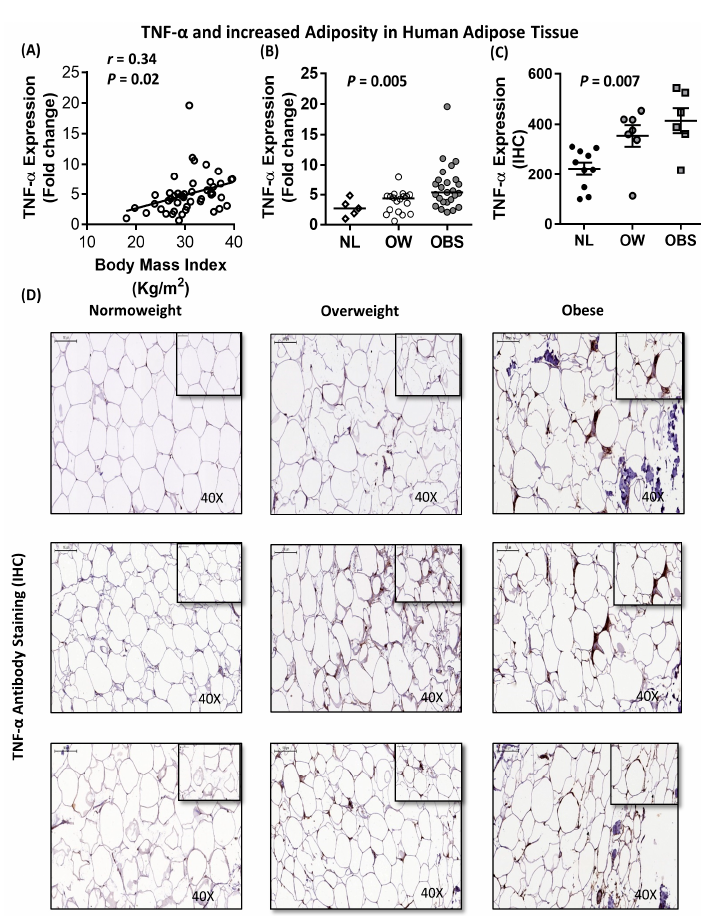
Figure 9. Association between TNF- α and increased adiposity in human adipose tissue. Subcutaneous adipose tissue was obtained from individuals with normoweight, overweight or obesity. ( A ) Direct correlation between adipose tissue TNF- α mRNA expression and the BMI. ( B , C ) Increased adipose tissue TNF- α mRNA and protein expression with increasing adiposity. TNF- α mRNA expression was detected by real-time RT-PCR and represented as fold change over controls. TNF- α protein expression was detected by immunohistochemistry and represented as staining intensity based on Aperio-positive pixel counts (Aperio software algorithm version 9.0). ( D ) Representative images are presented for TNF- α protein expression in the adipose tissue from individuals with normoweight, overweight or obesity. The arrowheads point to cells with intense staining for TNF- α protein. Correlation analysis was conducted using the non-parametric Spearman’s r test, and the group medians were compared using the non-parametric Kruskal-Wallis